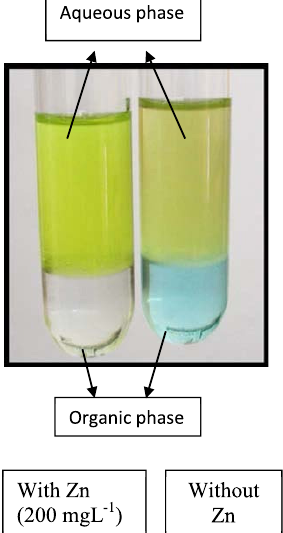
Fig. 2. Effect of Zn(NO in nutrient broth